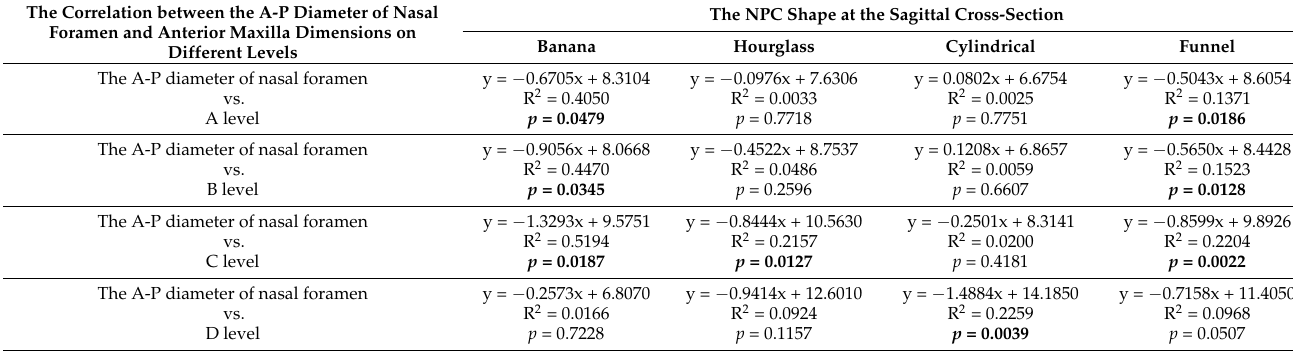
Table 5. The correlation between the A-P diameter of nasal foramen and anterior maxilla dimensions at predefined portions depending on the canal shape at the sagittal cross-section.